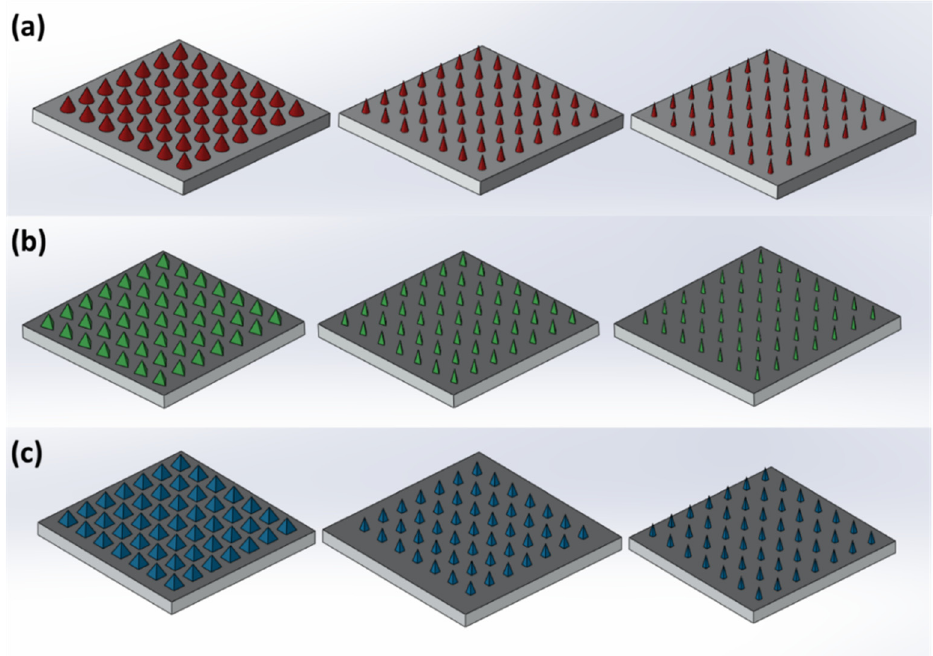
Figure 1. CAD design of the MNs on SolidWorks. ( a ) Pyramid, ( b ) 3-sided pyramided and ( c ) 4-sided pyramids. Height to aspect ratio from left to right (1:1, 2:1 and 3:1).